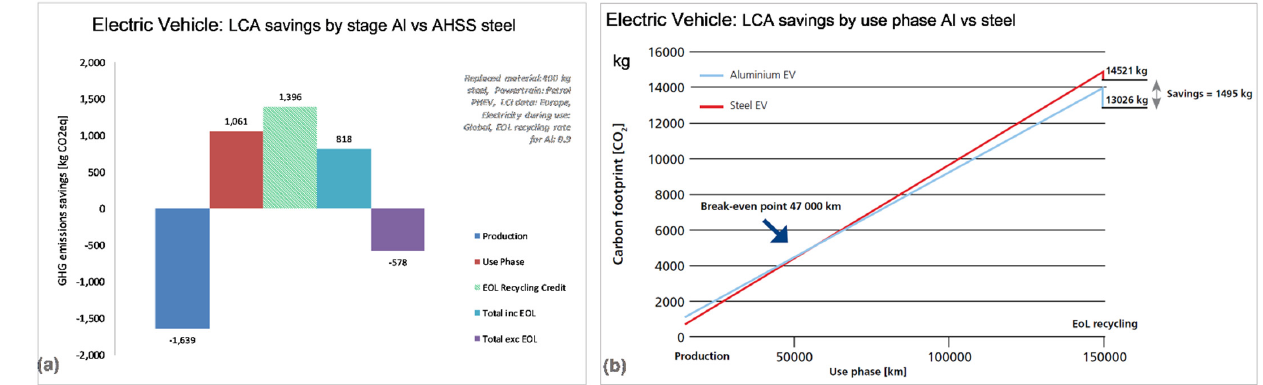
Figure 13. Example of Life Cycle Assessments of AHSS steel and aluminum in electric cars: ( a ) savings by stage and ( b ) savings by use phase. Details of the model, developed by the European Aluminum, are available from [66].